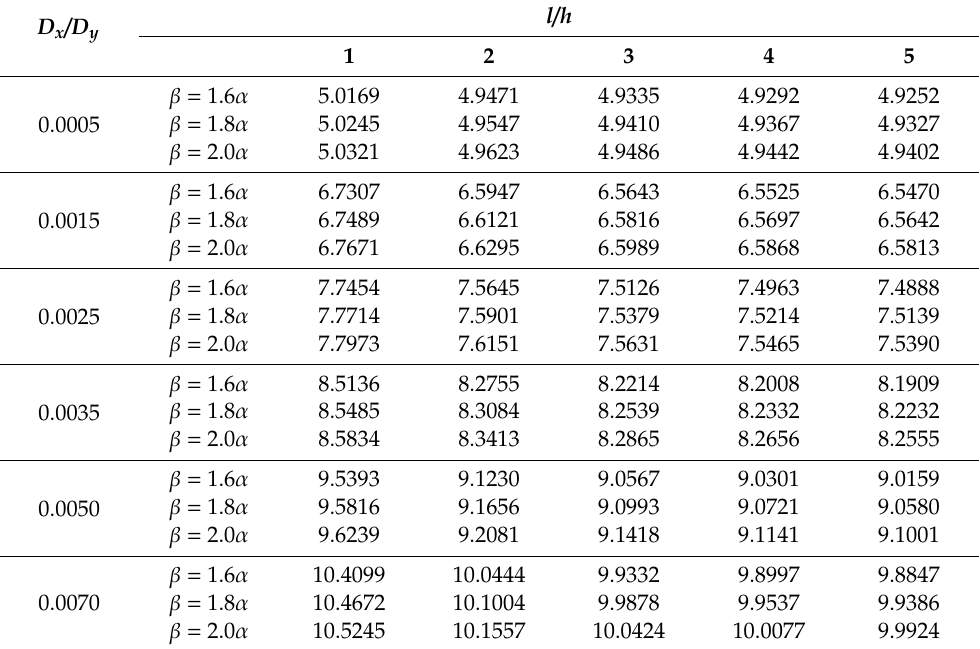
Table 2. The e ff ect of β / α on the global shear buckling coe ffi cient k g,s when h 2 / ( Rd ) = 5 and γ = 0.4 for the four-edge simple